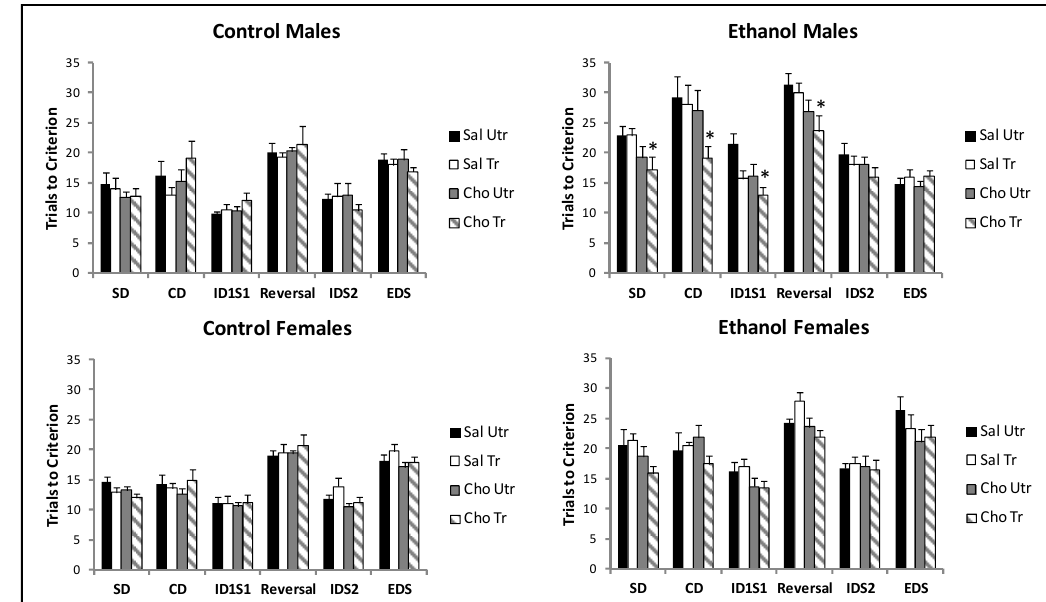
Figure 2. Attentional set shifting and reversal learning in young adult rats. In most phases, male and female rats prenatally exposed to ethanol required more trials to reach criterion than control rats. Choline supplementation reduced the number of trials in some phases in both sexes. The combination of working memory training and choline was more effective than either alone in males. Bars represent the Mean ± SEM, n = 7–9 per group. * Denotes a significant difference compared to Sal Utr rats in the same prenatal condition. CT = Control, ET = Ethanol; Sal = Saline, Cho = Choline; Utr = No Working Memory training, Tr = Working Memory training.